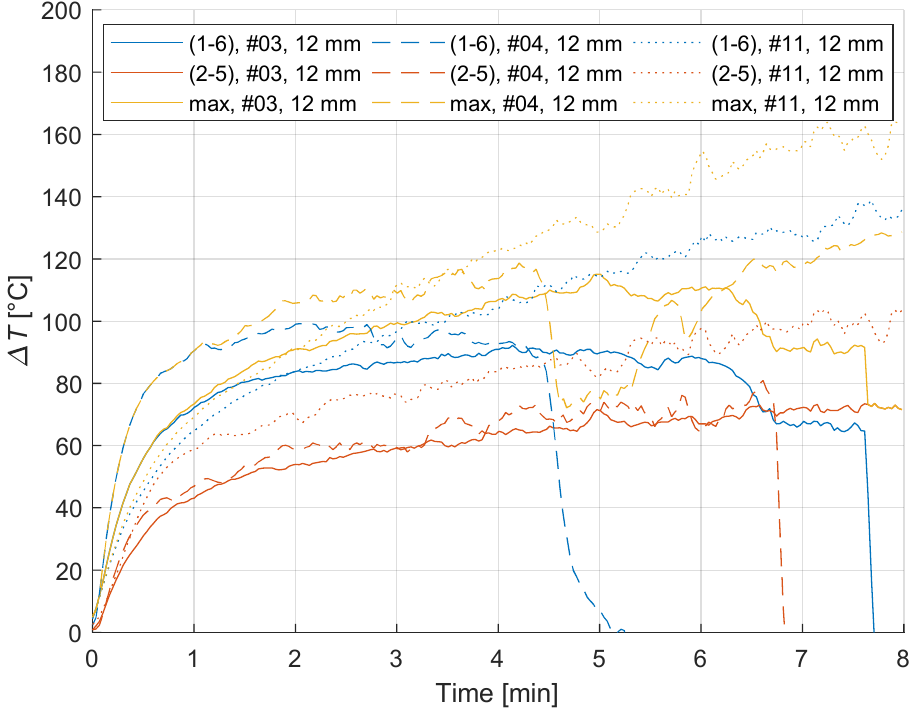
Figure 9. Maximal horizontal (1–6), vertical (2–5), and total (max) temperature differences for 12 mm specimens (Test #3, #4 and #11).